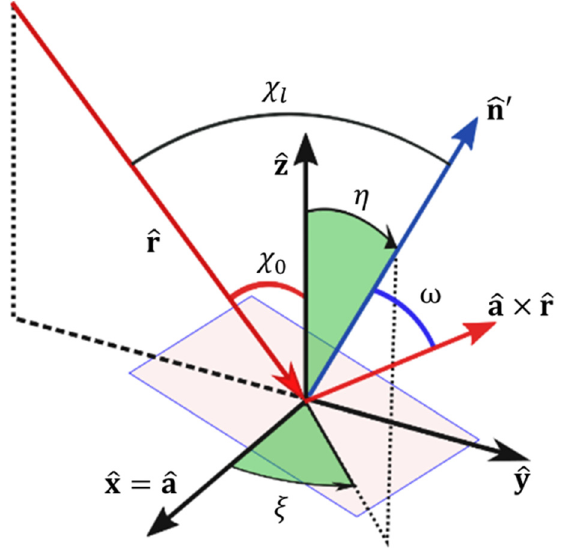
(cid:48) ^ n is the surface unit normal, χ l is local (cid:18) (cid:19) ^ = ^ x a are the vertical and azimuth directions,